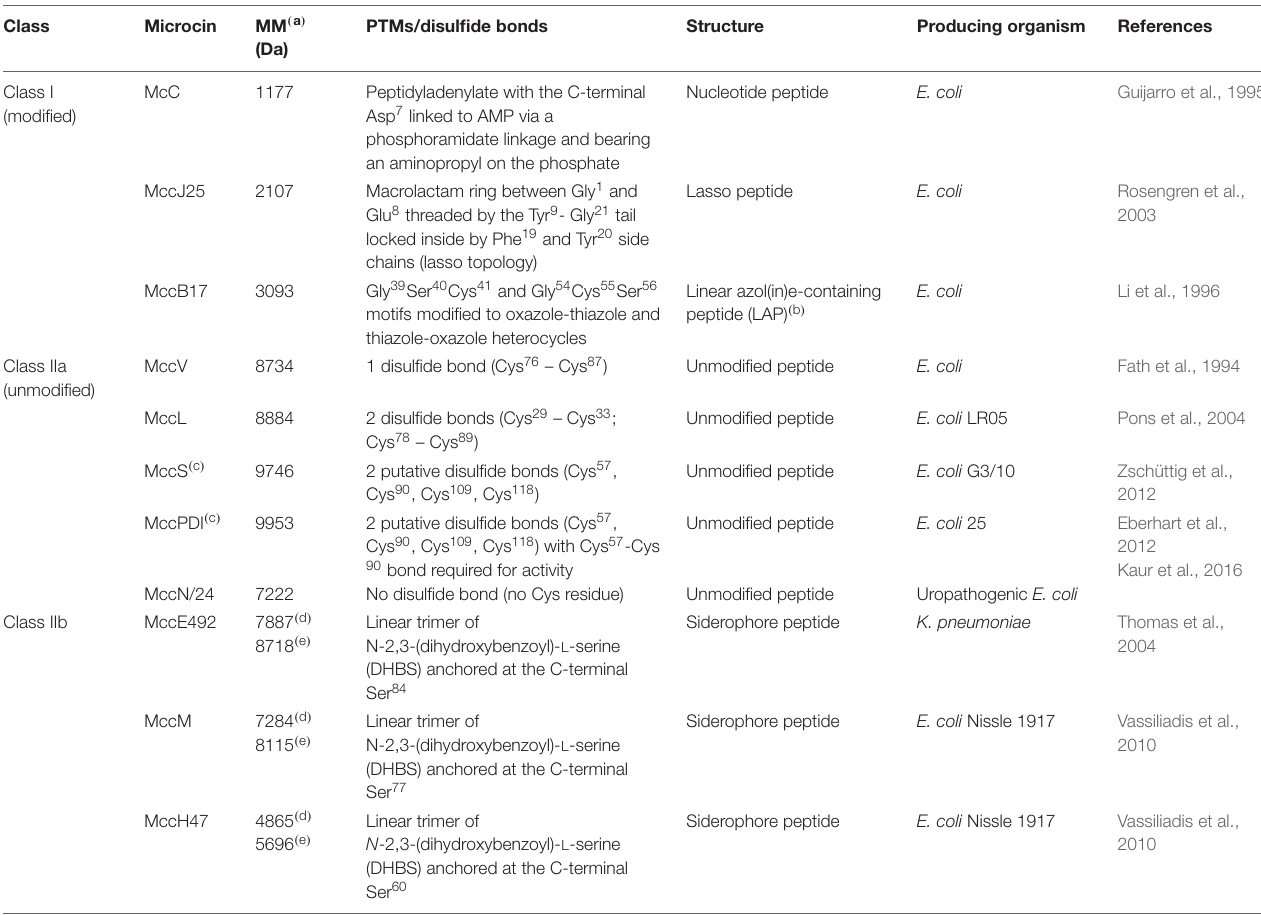
TABLE 1 | Structural characterization of microcins assembled into posttranslationally modified microcins (classes I and IIb) and unmodified microcins (class IIa) that contain or not disulfide